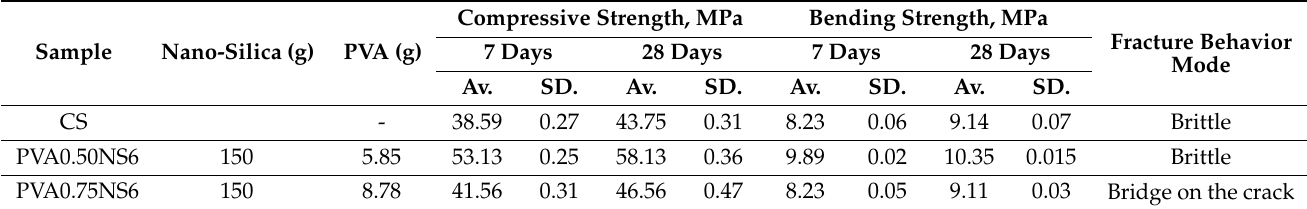
Table 10. Compressive and bending strengths of mortar containing PVA and optimum percentages of NS.